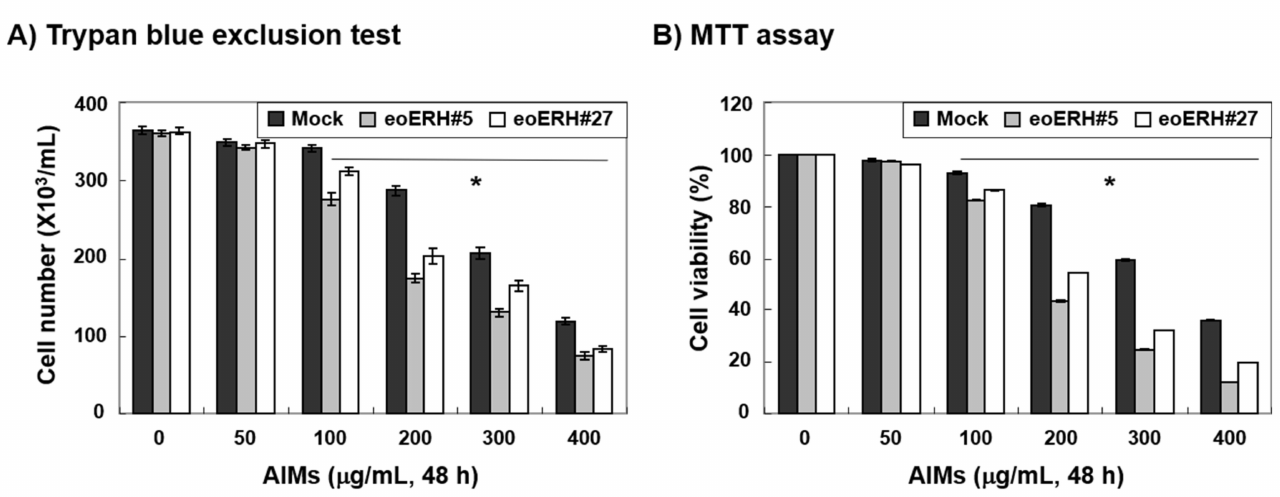
Figure 1. Enhancer of rudimentary homolog (ERH)-augmented antiproliferative effect on AIM-treated MKN28 cells. The cells were seeded at the density of 5 × 10 4 cells per mL. The two kinds of ERH-transfected MKN28 cells (E-MKN28 cells: eoERH#5 and eoERH#27) and mock-treated MKN28 cells (M-MKN28 cells) were treated with AIMs at indicated concentrations (up to 400 µ g/mL). The efficacy of ERH gene on AIM-induced antiproliferative activity was greatest at the concentration of 200 µ g/mL of AIMs. The inhibition of cell proliferation was measured by ( A ) trypan blue exclusion test and ( B ) MTT assay. The data are shown as means ± SD of three independent experiments. ‘*’ represents significance (* p < 0.05 between AIM-treated E-MKN28 cells and AIM-treated M-MKN28